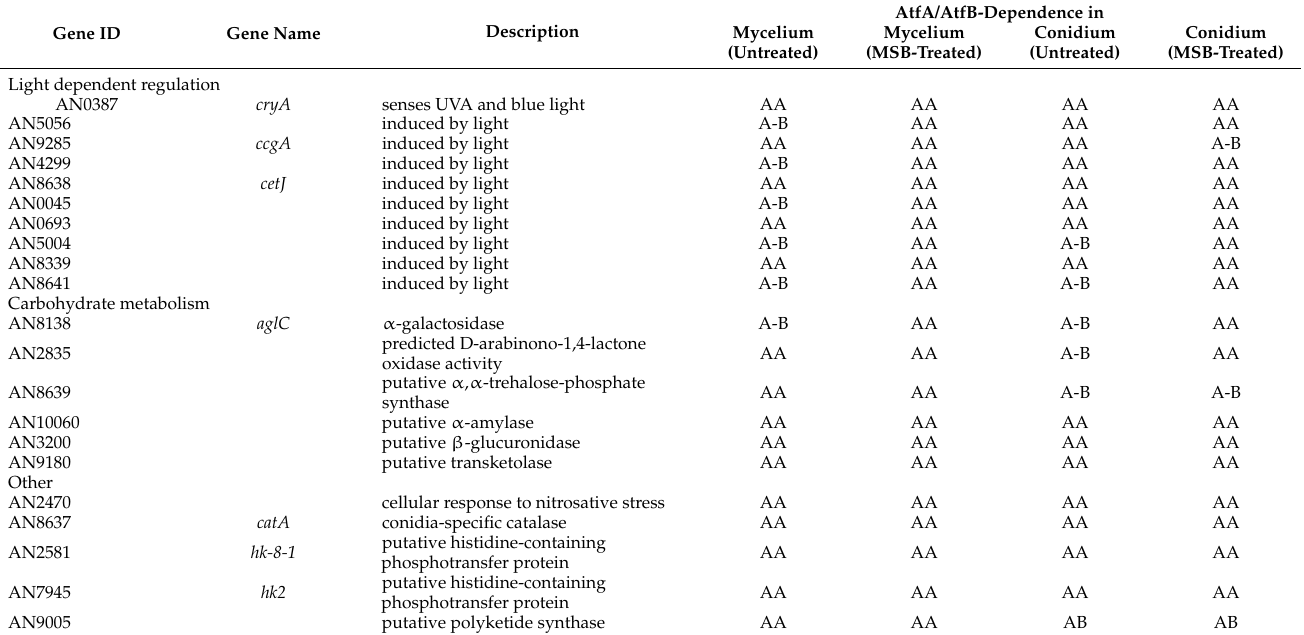
Table 5. Selected genes showing AtfA-dependent in all